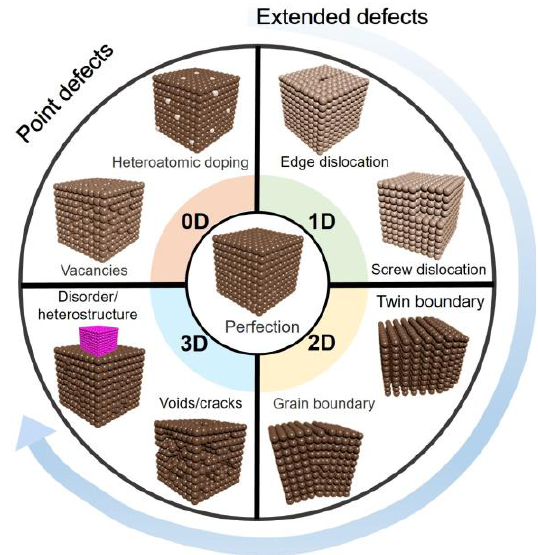
Figure 1. Types of defects in materials [3].